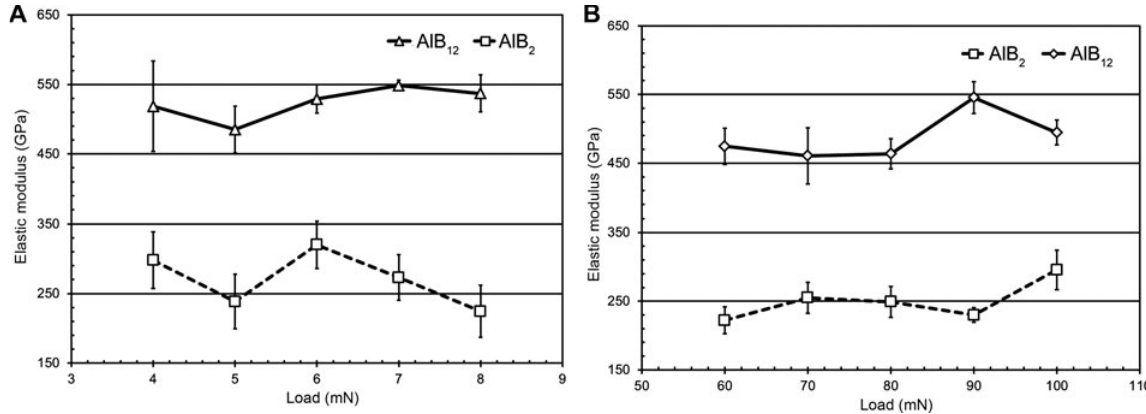
Figure 7 Elastic modulus of AlB